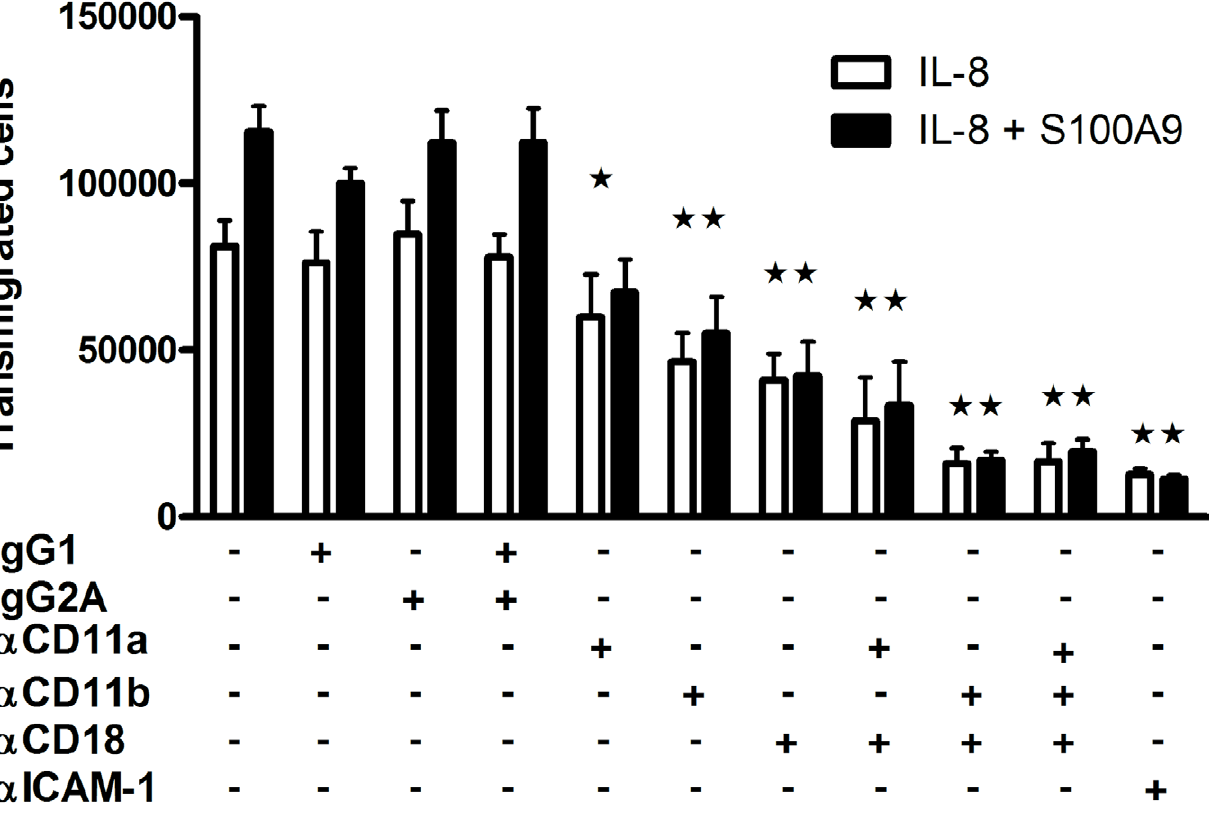
Figure 8. The effect of S100A9 on neutrophil migration is abolished by anti-CD11b and anti-CD18 antibodies. S100A9 (40 m g/ml) + / 2 antibodies against CD11a, CD11b, and CD18, or the isotype control were added to the upper wells with neutrophils. IL-8 (5 ng/ml) or buffer was added to the lower wells and neutrophils were allowed to migrate for 2 h at 37 u C. The number of transmigrated cells was determined as described in Materials and Methods. Data shown represent the mean 6 SEM of at least 3 experiments using neutrophils from different donors. *p , 0.05, **p , 0.01, one-way ANOVA, Dunnett’s multiple comparison test.